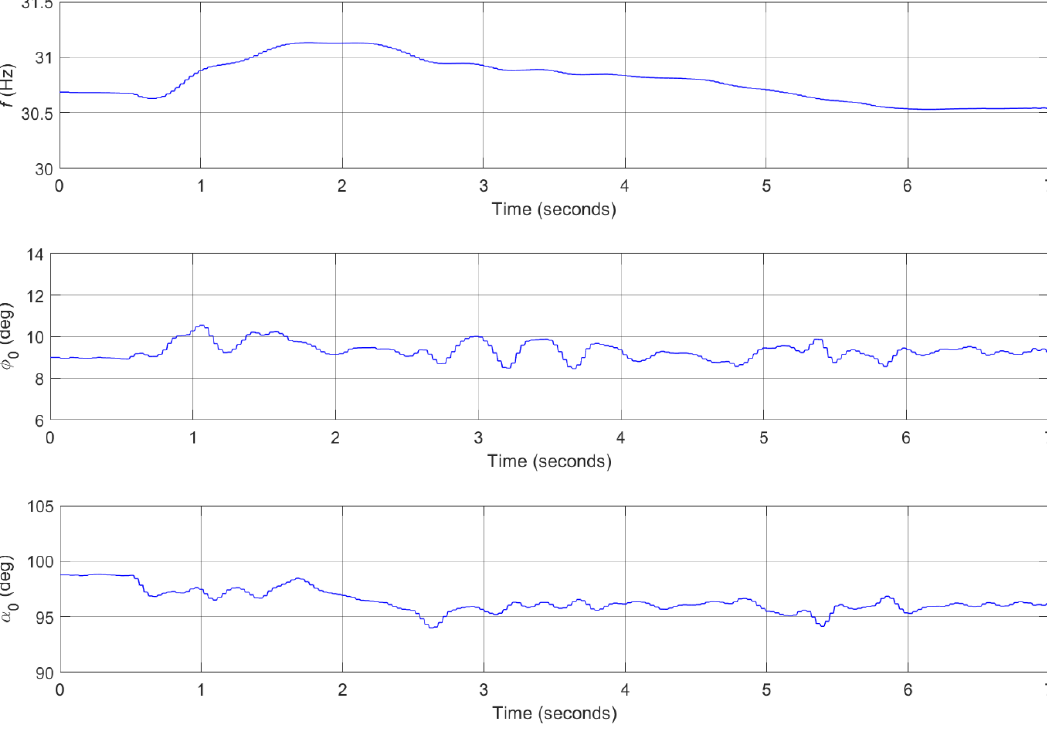
Figure 26. Flight control inputs for trajectories tracking control of nonlinear FWMAV model (case 2).